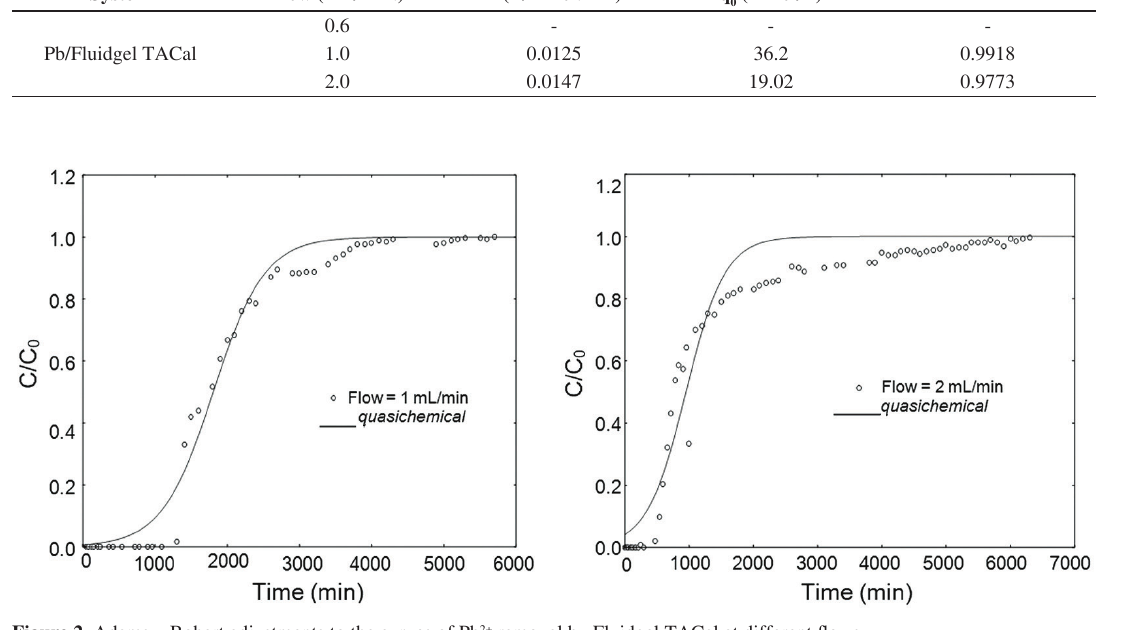
Figure 2. Adams – Bohart adjustments to the curves of Pb 2+ removal by Fluidgel TACal at different